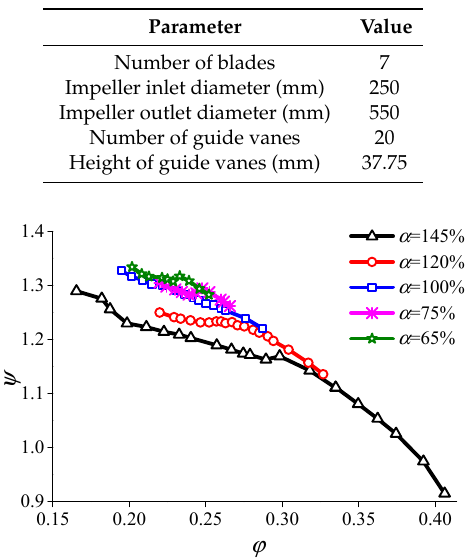
Figure 3. Experimental pump performance curves at various guide vane openings (GVOs).